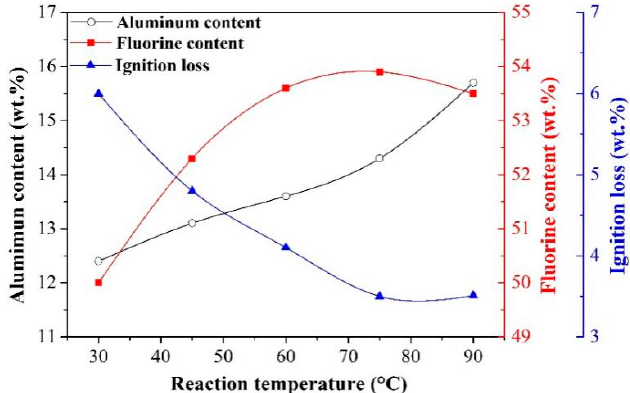
Figure 10. E ff ect of reaction temperature on the aluminum content, fluorine content, and ignition loss of synthetic cryolite.